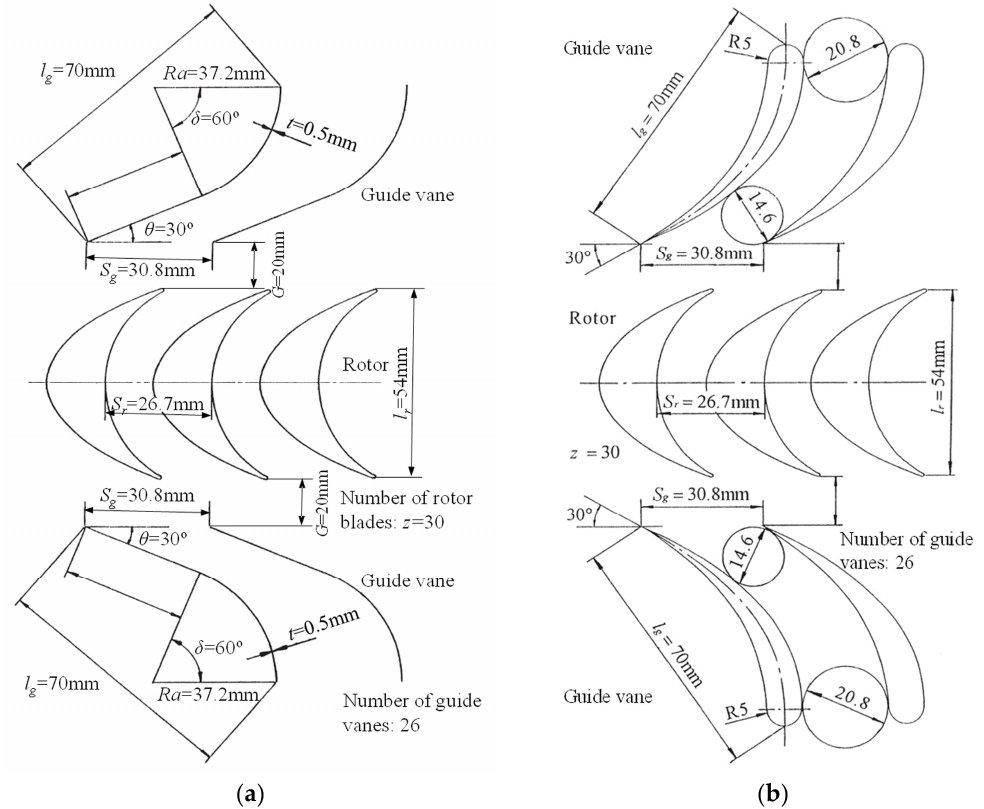
Figure 2. Reference geometry with plate guide vane ( a ) and airfoil guide vane ( b ) (figures adapted from [5]).